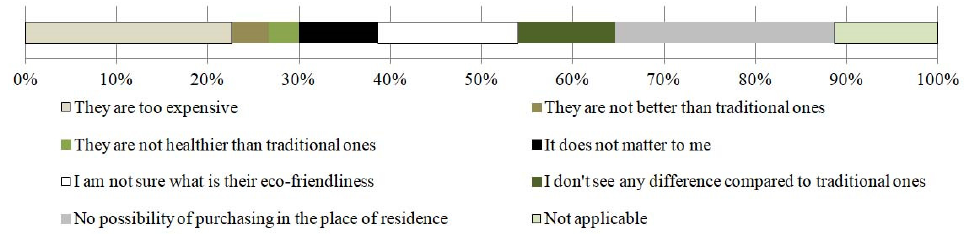
Figure 6. Reasons for not purchasing organic vegetables [%].